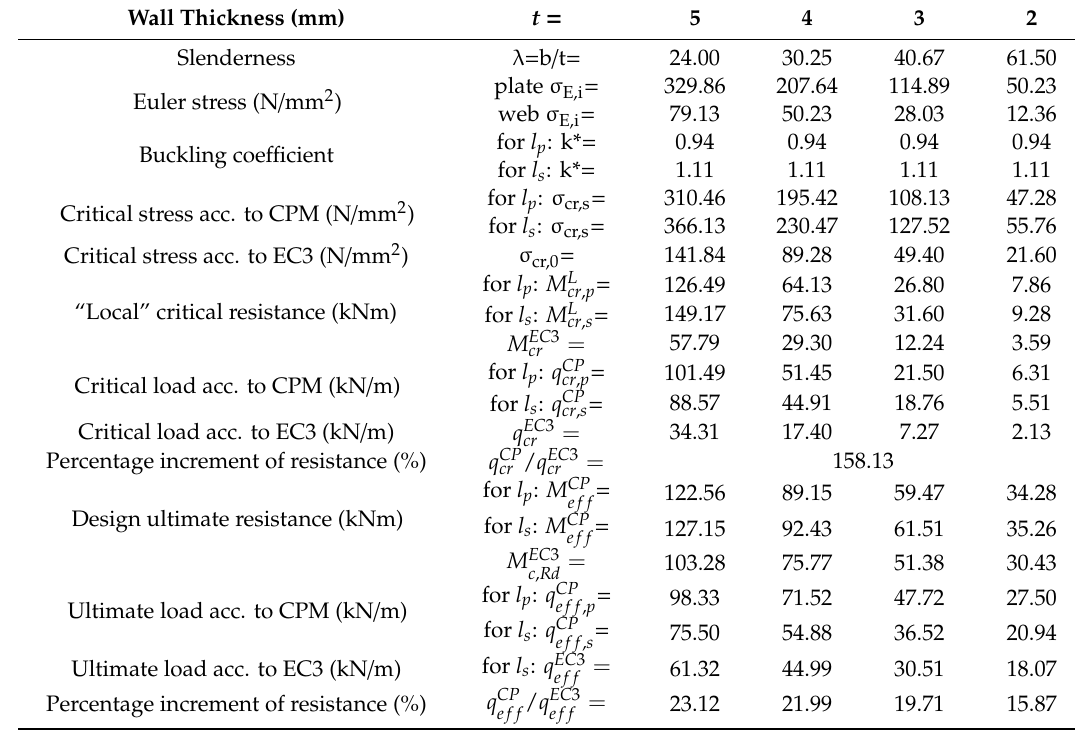
Table 7. Summary of results according to CPM and EC3 for the 2C-250 × 250 × t section and four wall thickness variants.